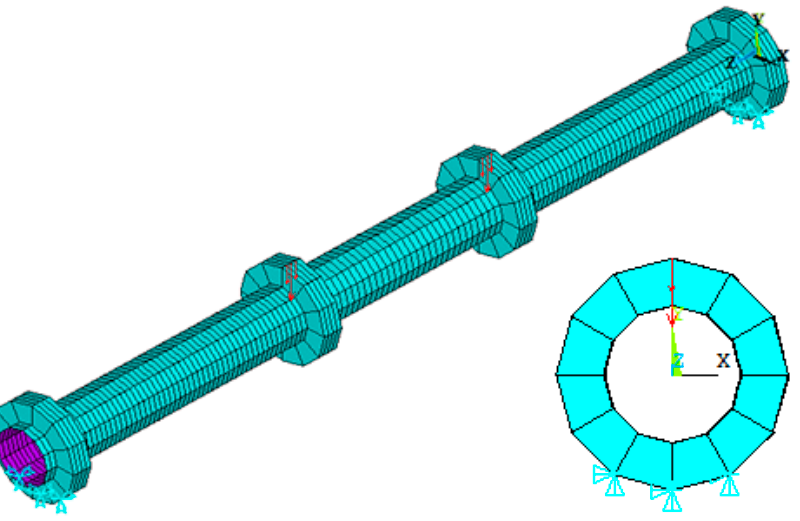
Figure 8. Boundary conditions and applied load on the specimen.